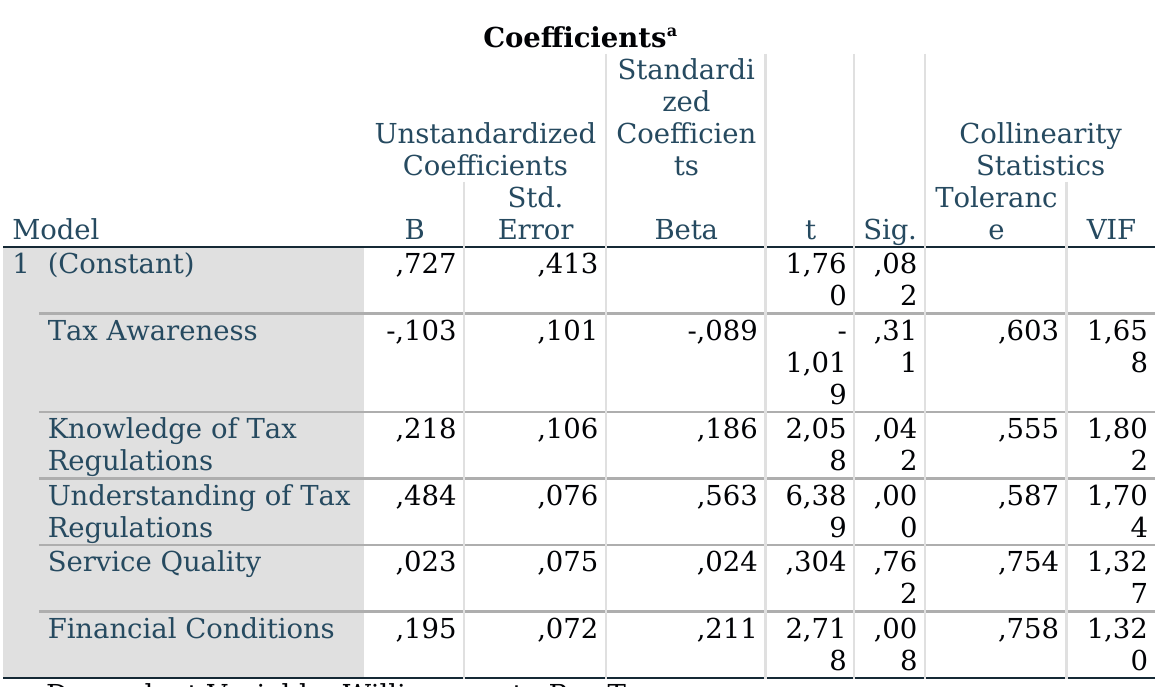
Table 1. Regression Coefficient